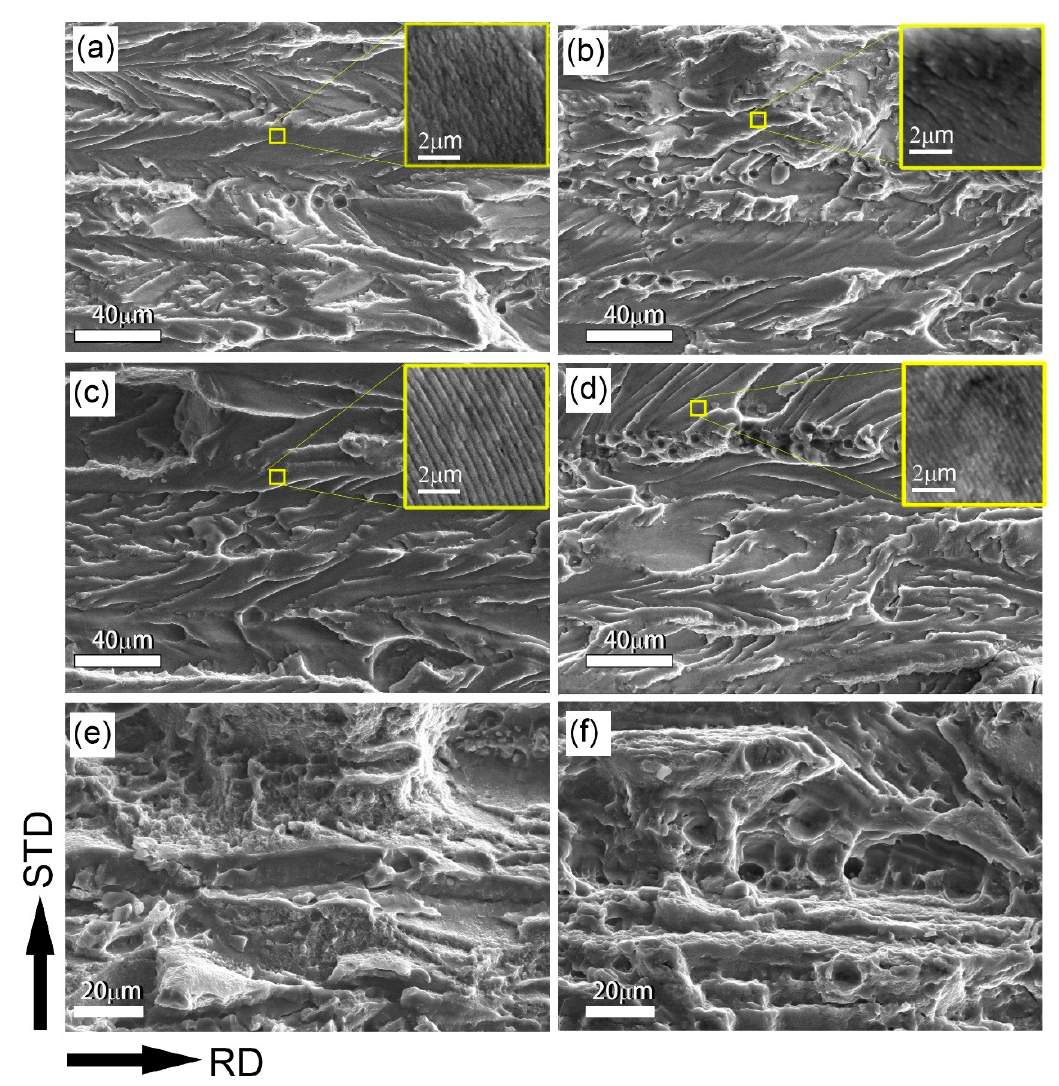
Figure 3. SEM characterization of fractography of T-L direction samples after retrogression at 180 ° C for 1 h (first column) and 2 h (second column). Images ( a , b ) are taken from stage I-crack initial, ( c , d ) are taken from stage II-crack steadily propagation, and ( e , f ) are taken from stage III- catastrophic failure. The enclosed image in the top-right corner shows higher magnifications of the fatigue striations produced from amplitude loading.